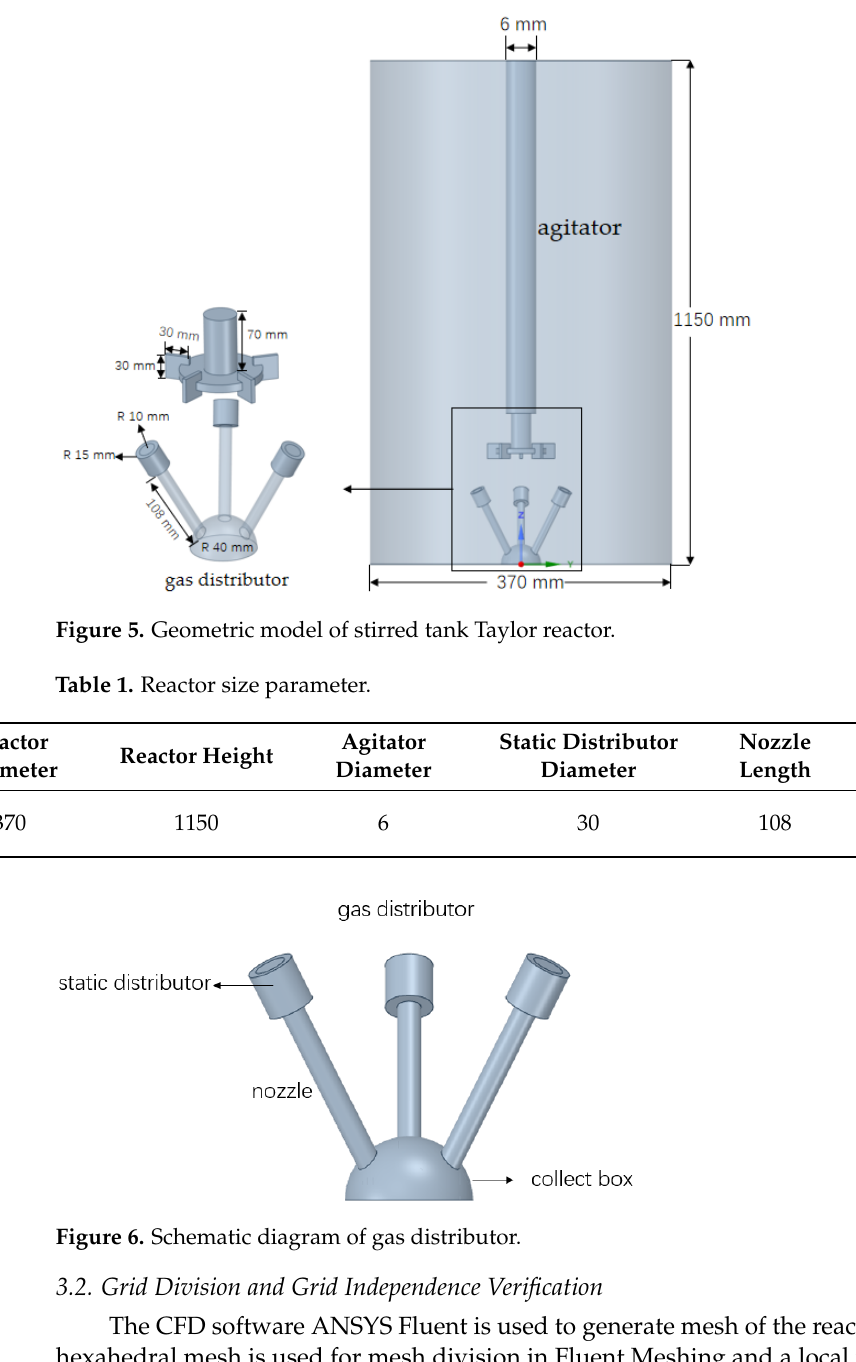
Table 1. Reactor size parameter.